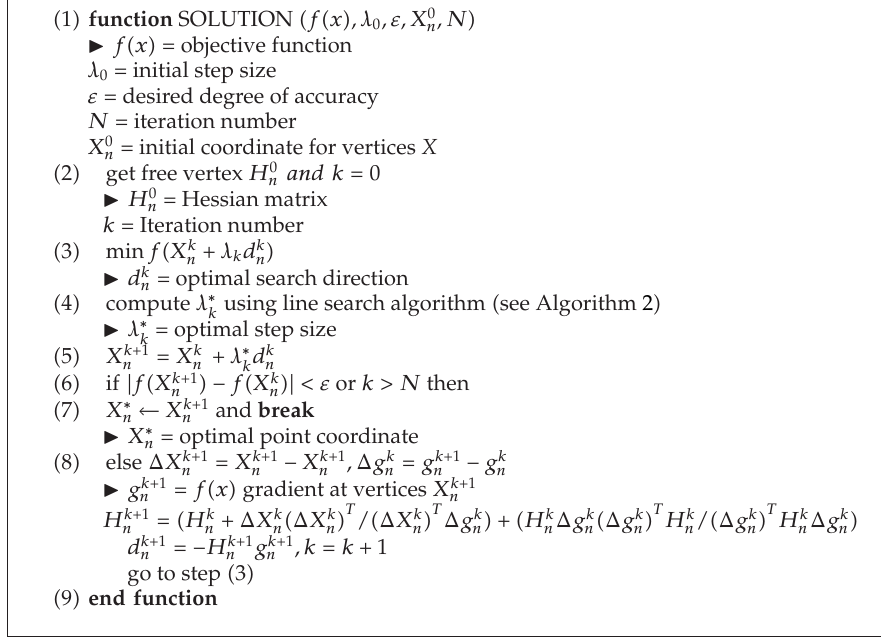
Algorithm 1: Nonsmooth optimization